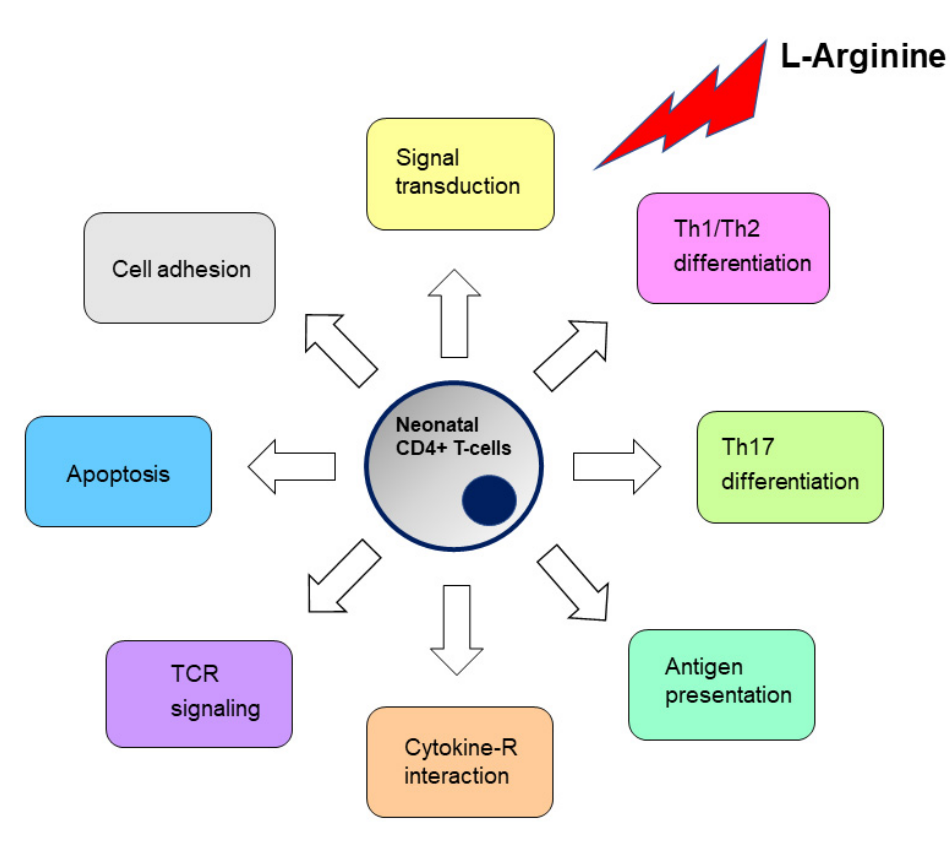
Figure 7. Regulatory effects of L -arginine on neonatal CD4 + T cells via DNA methylation modifica- tion.